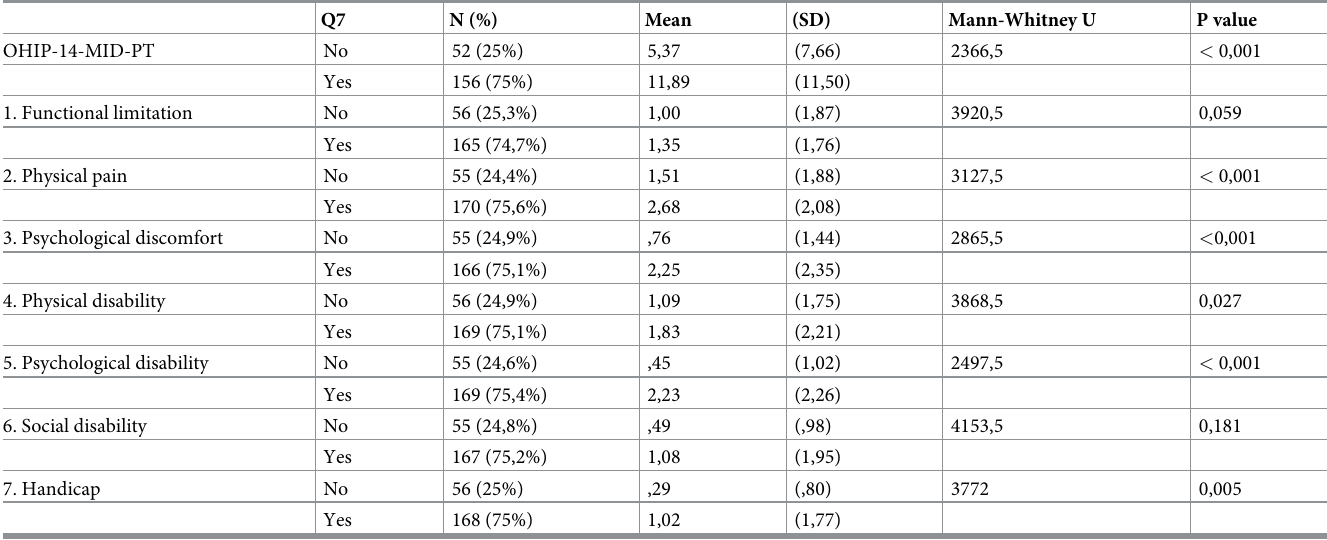
Table 1. Portuguese language validation of